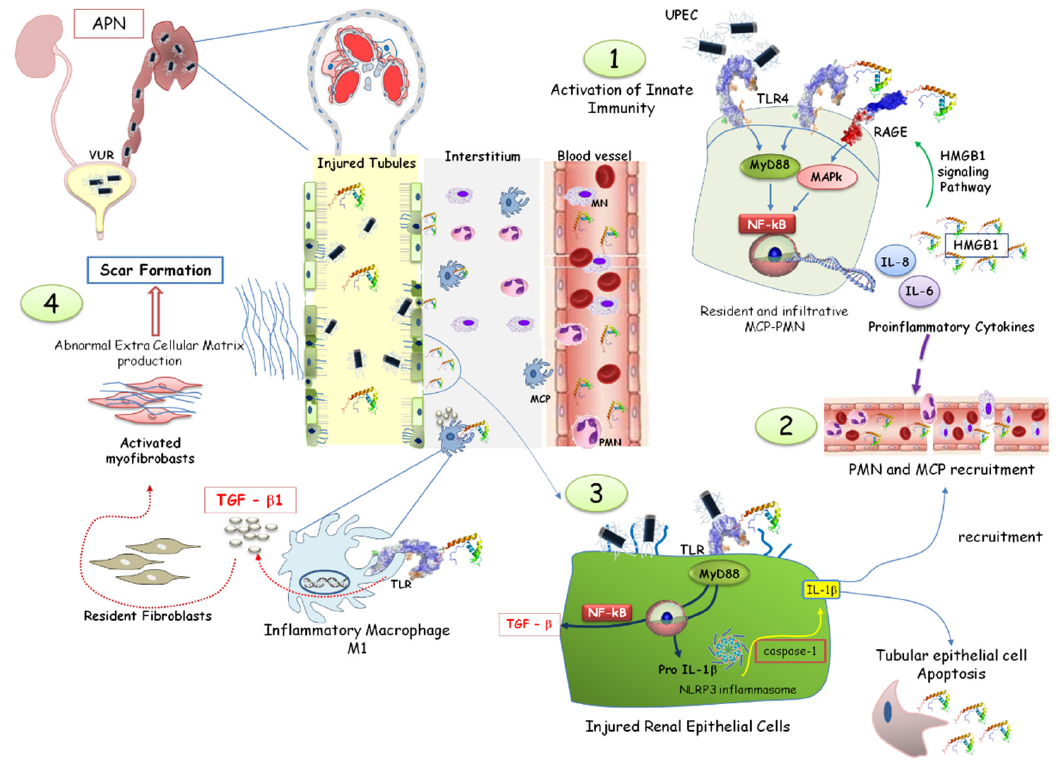
Figure 5. HMGB1 involvement in acute pyelonephritis. Neutrophils (PMN) and macrophages (MCP) are activated by HMGB1, recognized by the toll-like receptor (TLR), leading to the activation of the NF-system and the synthesis of pro-inflammatory proteins ( 1 , 2 ). HMGB1-mediated pathways promote the assembly of the NLRP3 inflammasome, amplifying the inflammatory response and immune cell recruitment. HMGB1 promotes TGF- β 1 synthesis by renal epithelial cells through the NF- κ B pathway ( 3 ). In the interstitial renal tissue, activated monocytes differentiate into M1 macrophages, producing TGF- β . The consequent myofibroblast activation, proliferation, and extracellular matrix deposition induced a vicious circle increasing HMGB1 and TGF- β synthesis. Renal fibrosis and scar formation represented the final process ( 4 ).